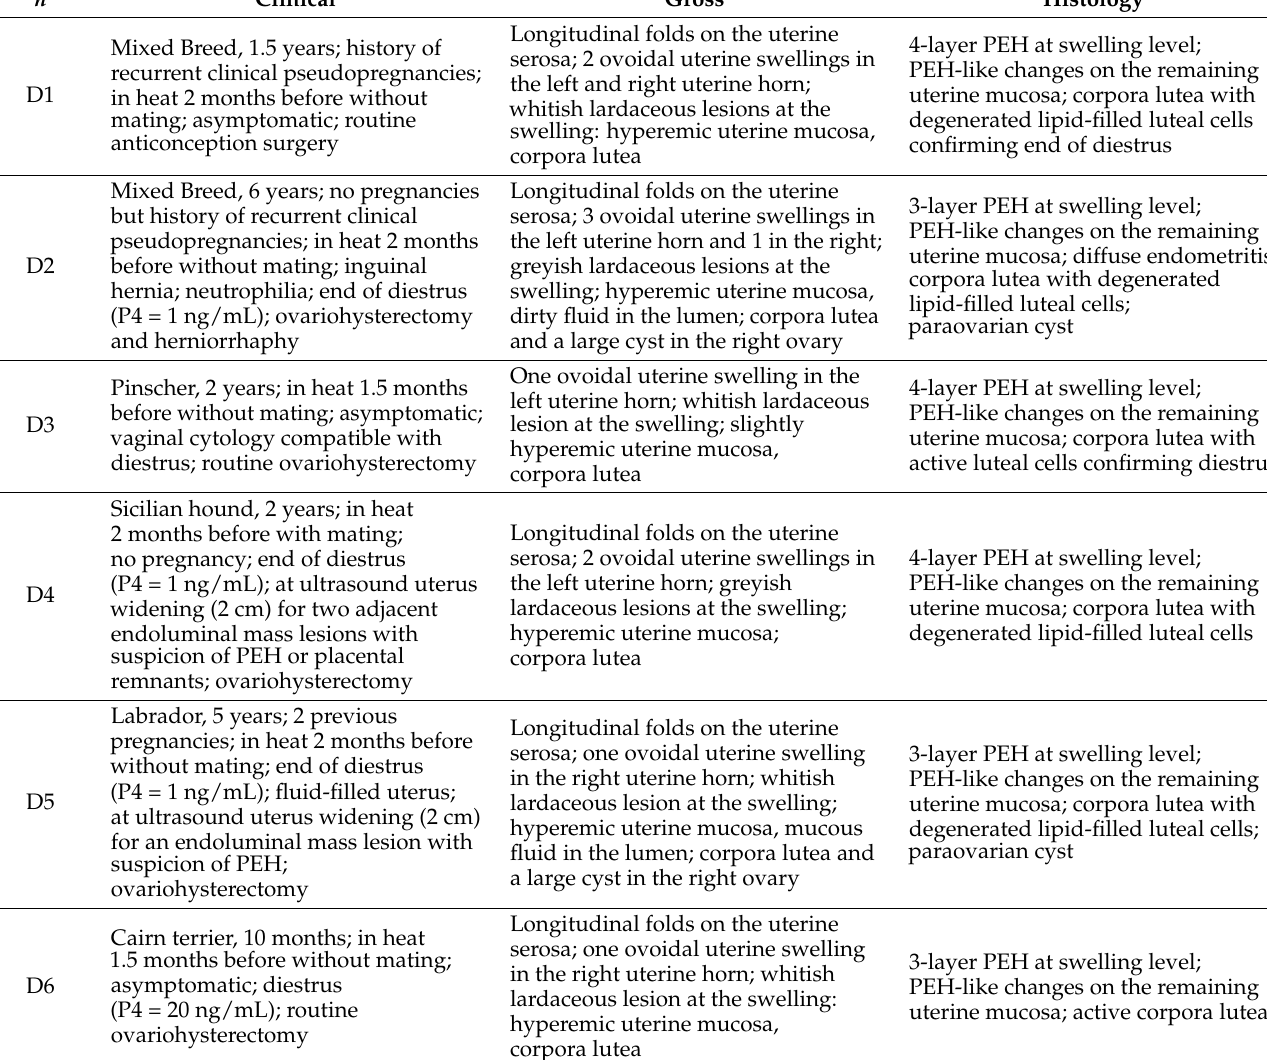
Table 1. Clinicopathological findings of the cases of pseudo-placentation endometrial hyperplasia (PEH). P4 = progesterone. n Clinical Gross